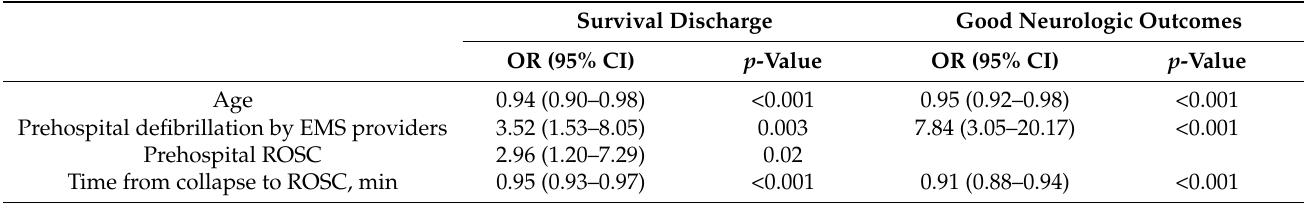
Table 2. Predictors of survival discharge and good neurologic